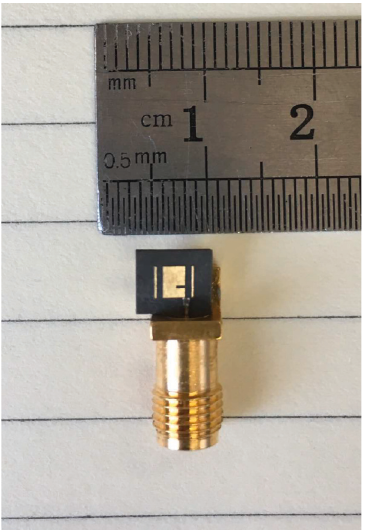
Figure 12: Photographs of the fabricated CP antenna showing the patch view.